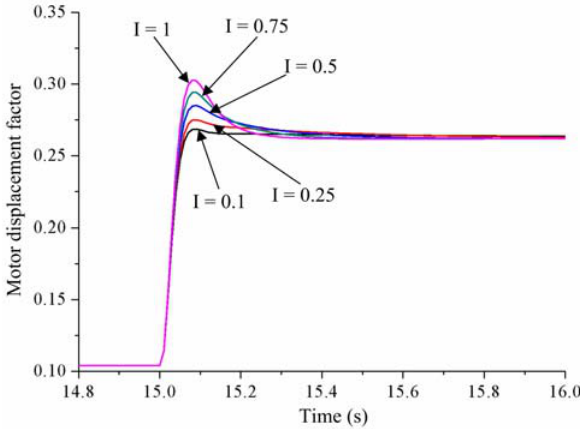
Figure 8. Simulated motor displacement responses of the HESGS with different integral gains.